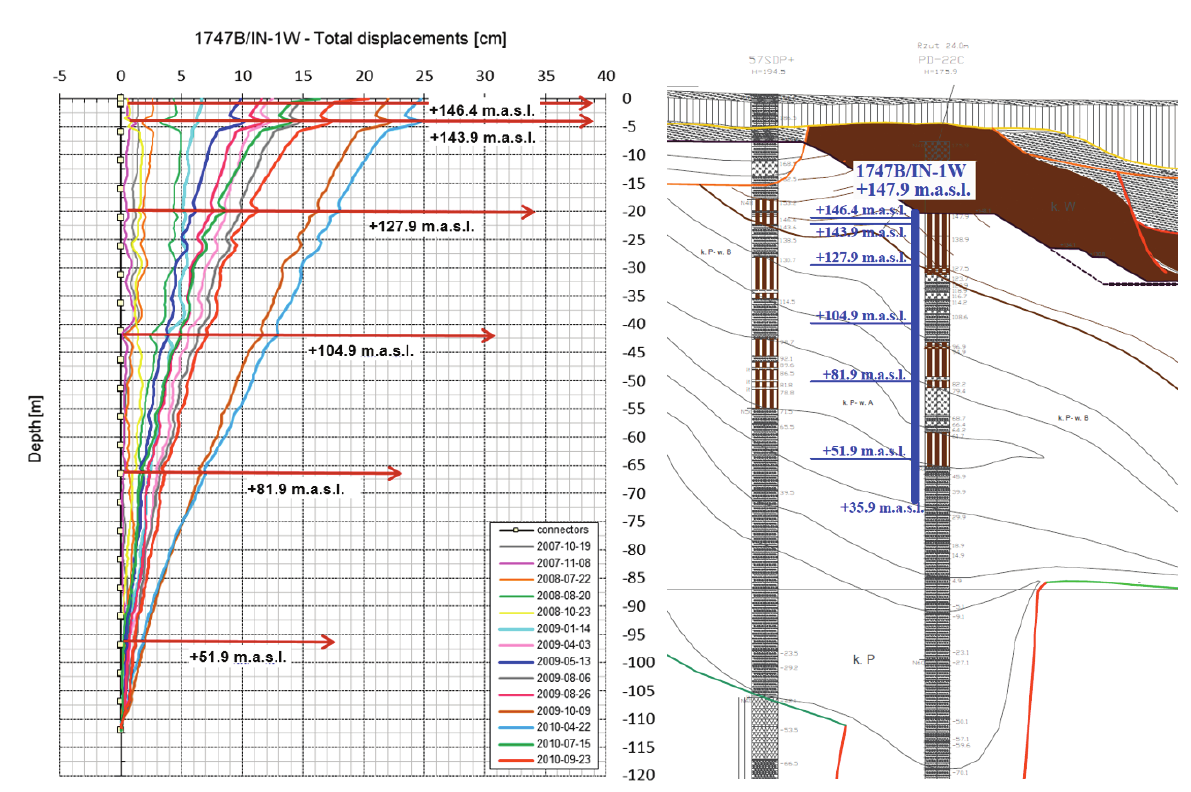
Fig. 7. The total horizontal displacements measured in inclinometer 1747B/IN-1W and the geological profile with potential slip surfaces levels (based on